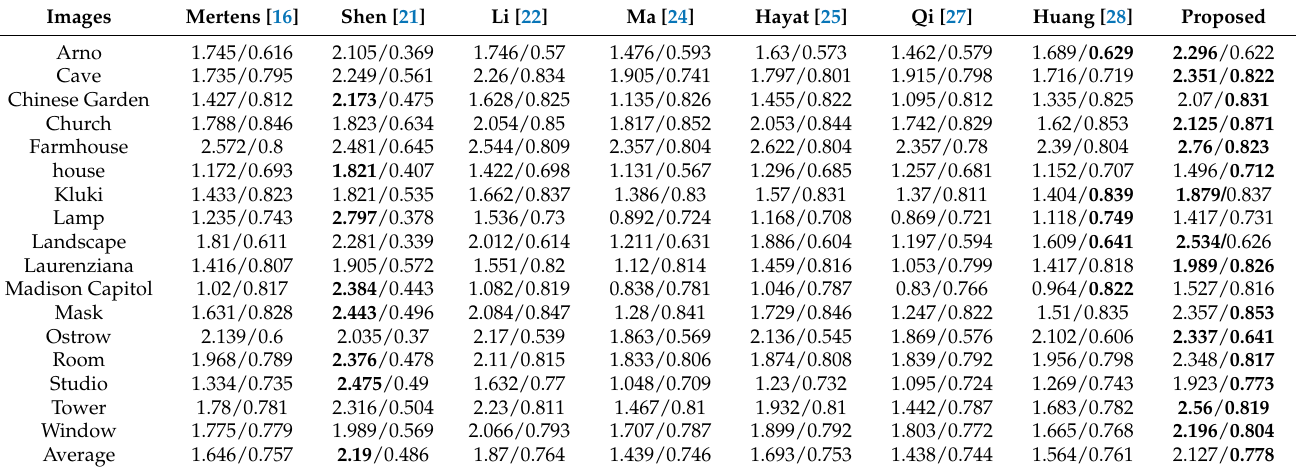
Table 3. Test results of DPA and Q AB / F .